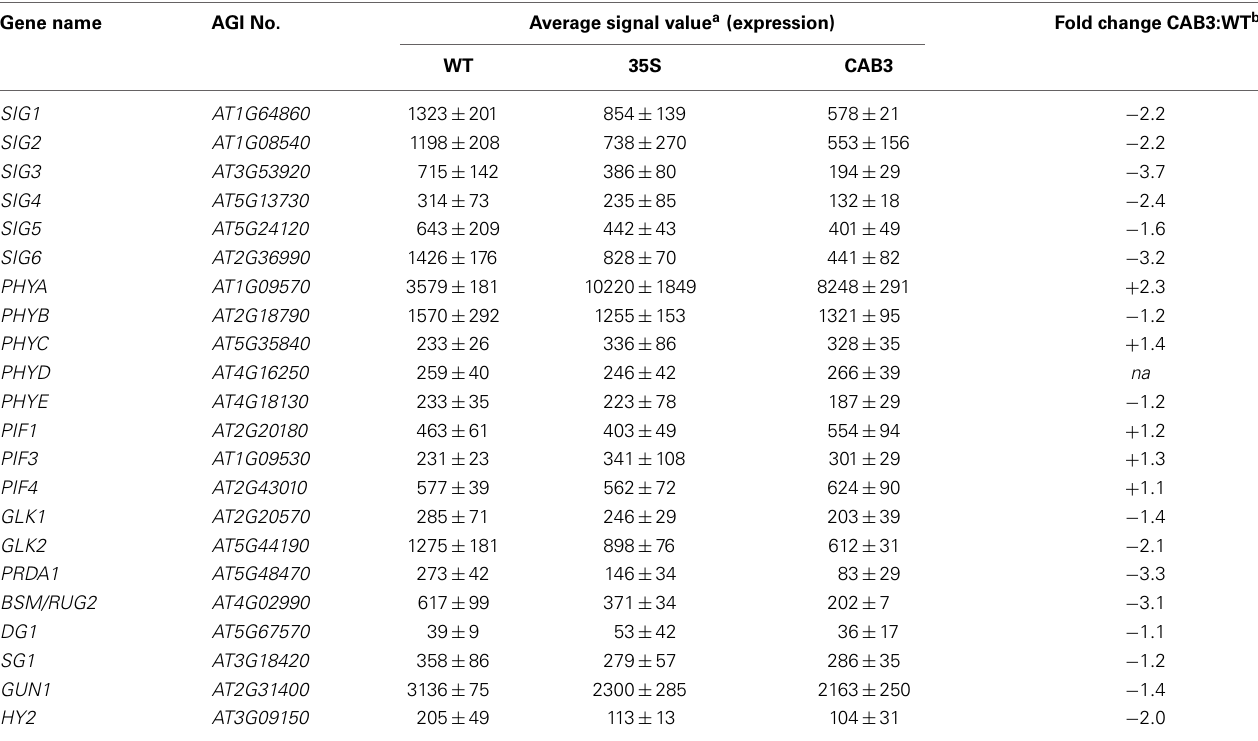
Table 2 | Known light signaling and chloroplast development